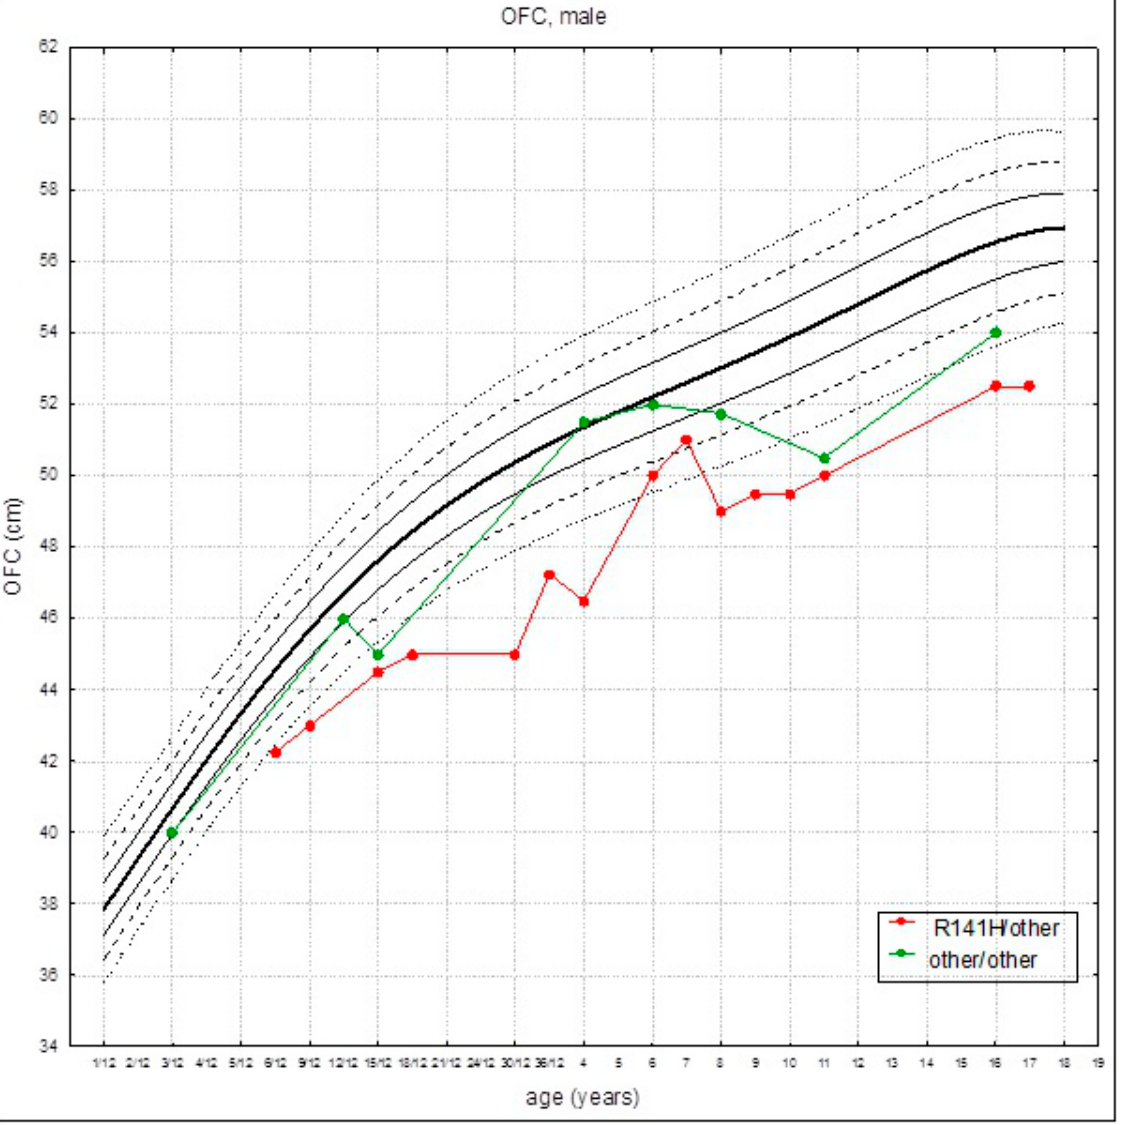
Figure 4. Head circumference curves (established on the average head circumference values) for patients with PMM2-CDG for the given genotypes: R141H/other (red marks) and other/other (green marks) on references growth charts for the healthy population.